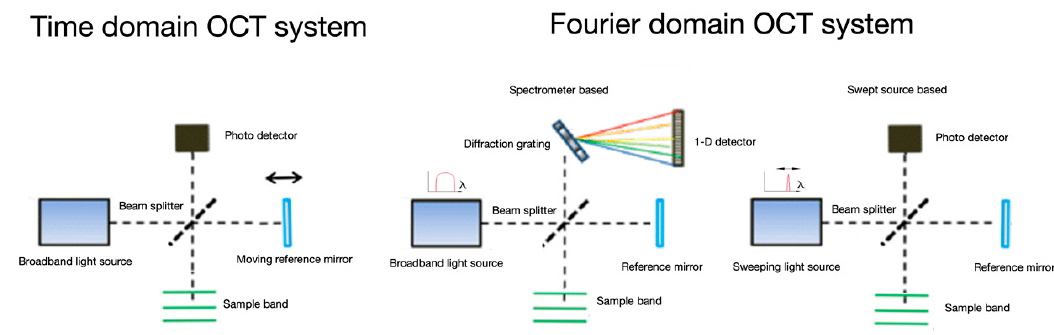
Figure 1. Schematic division of OCT